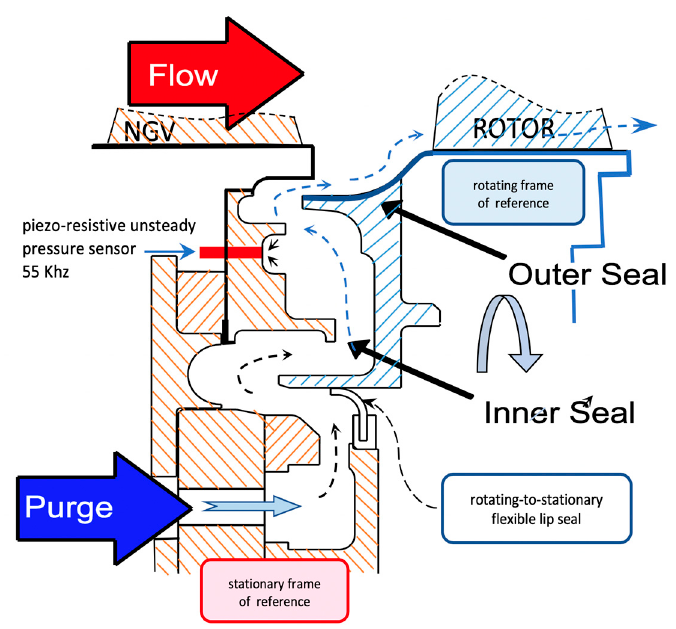
Figure 2. Rim seal cavity geometry and unsteady sensor location. NGV refers to nozzle guide vane.